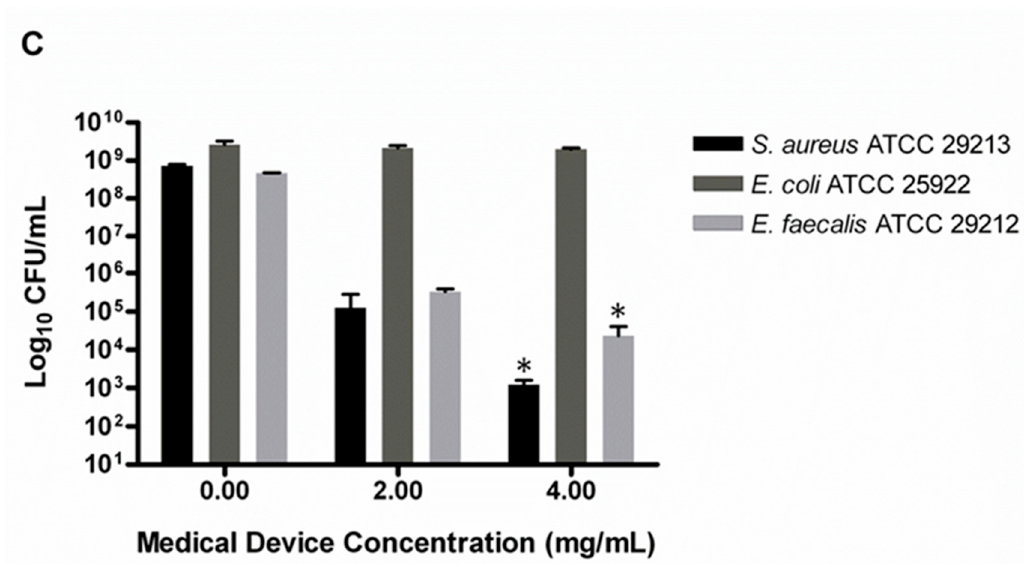
Figure 1. Evaluation of minimum inhibitory concentration (MIC) and minimum bactericidal concentration (MBC) of the medical device (MD) versus S. aureus , E. coli , and E. faecalis. The MIC was determined by Alamar Blue ® (AB) assay, which is based on the chemical reduction of resazurin (a non-toxic, cell-permeable, non-fluorescent, blue compound) in resorufin, which is a highly fluorescent red / purple compound. Such reduction is performed by viable cells; therefore, continued cell growth maintains a reduced environment, while the inhibition of growth or cell death induces an oxidized environment. ( A ) Representative image of colorimetric MIC determination using AB assay. The black circle indicates the MIC at 2 mg / mL which is the same for both S. aureus and E. faecalis . ( B ) The plot shows the percentage reduction of AB recorded for the three bacterial species at di ff erent MD concentrations compared to the corresponding untreated samples (0.00) performed as described in the Materials and Methods section. The percentage of AB reduction was evaluated by using absorbance at 570 nm and 600 nm. ( C ) The MBC was determined by CFU counts and corresponds to 4 mg / mL for S. aureus and E. faecalis . Data are the mean of three replicates of three independent experiments; * p < 0.05 vs. the controls (0.00). C: controls or untreated samples.